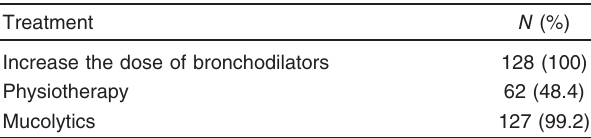
Table 16 Distribution of doctors as regards treatment given to chronic obstructive pulmonary disease patients in exacerbations